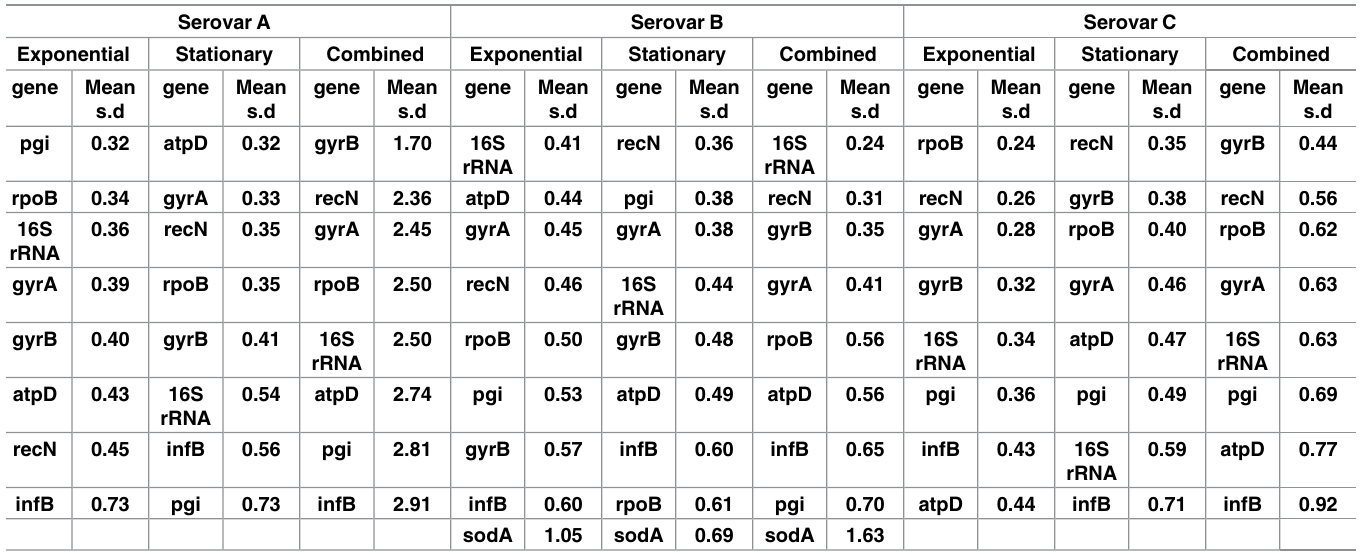
Table 8. Gene expressionstability assessedby the comparative Δ CT method.